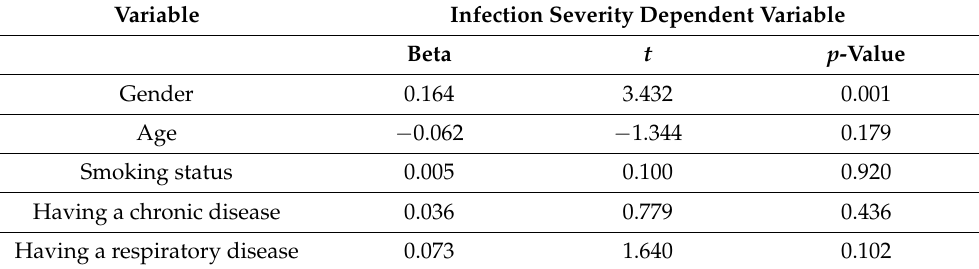
Table 4. Summary of the regression model obtained for the dependent variable ‘infection severity’ ( n =